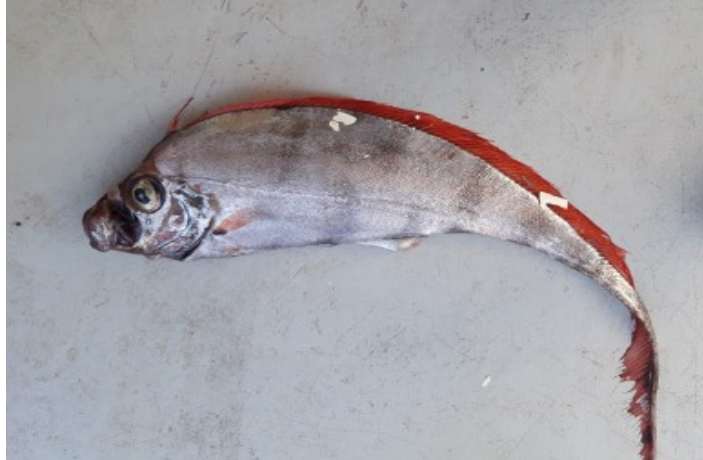
Figure 2. Z. cristatus specimen of this study just hoisted on board.